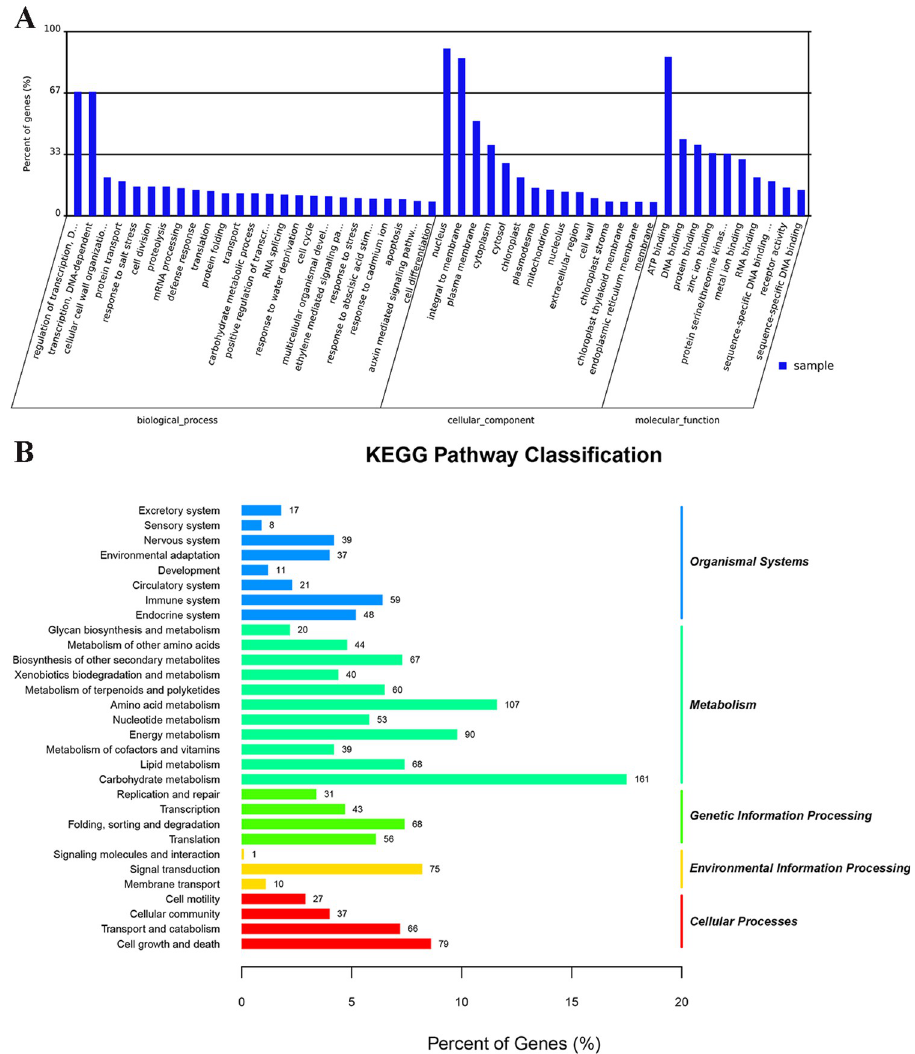
Fig 8. Annotation and enrichment analysis of targets for miRNAs. (A GO enrichment analysis of predicted targeted genes, B KEGG enrichment analysis of predicted targeted genes).